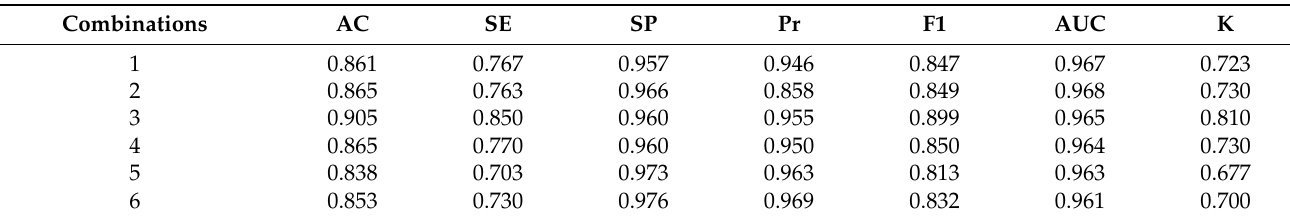
Table 4 lists the ensemble results for all combinations established by the method used. Table 4. Results obtained by combining the classifiers.